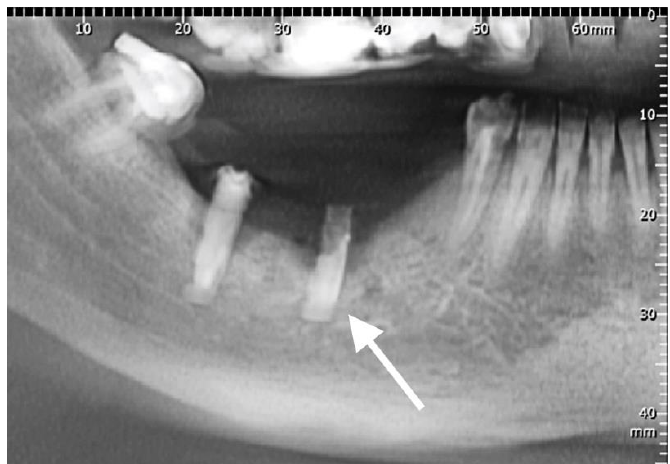
Figure 4. Radiography centered in quadrant 4 displaying incorrect positioning of inserted implants. Peri-implantitis with bone loss and exposure of the cervical segment of the implant are noted. The studied implant is marked with an arrow.